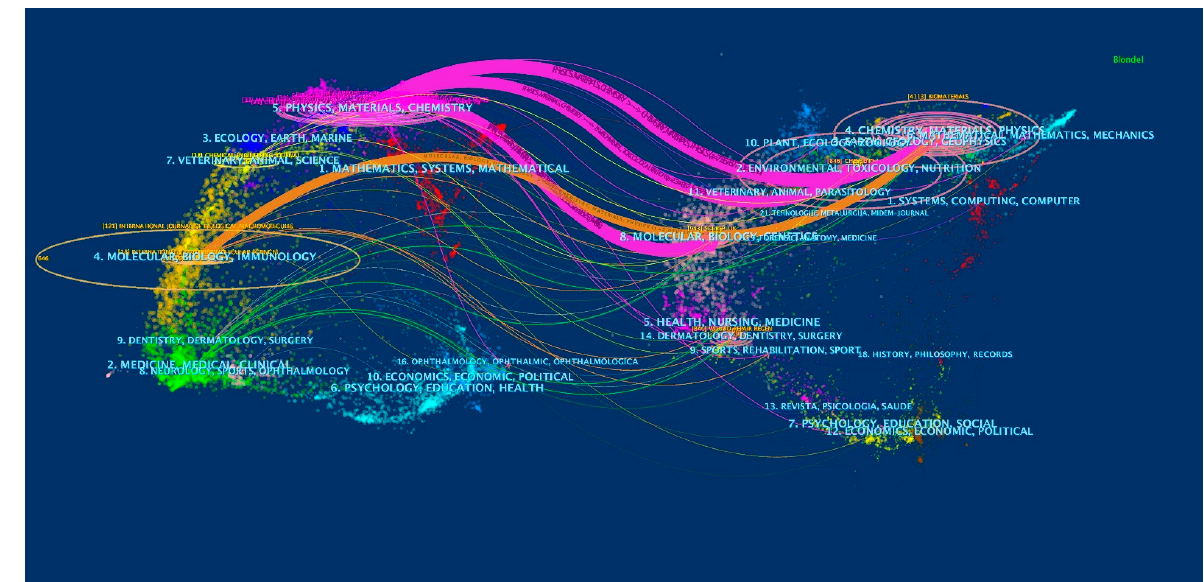
Figure 4. The dual-map overlay of journals related to NDSRSsin the wound healing field.